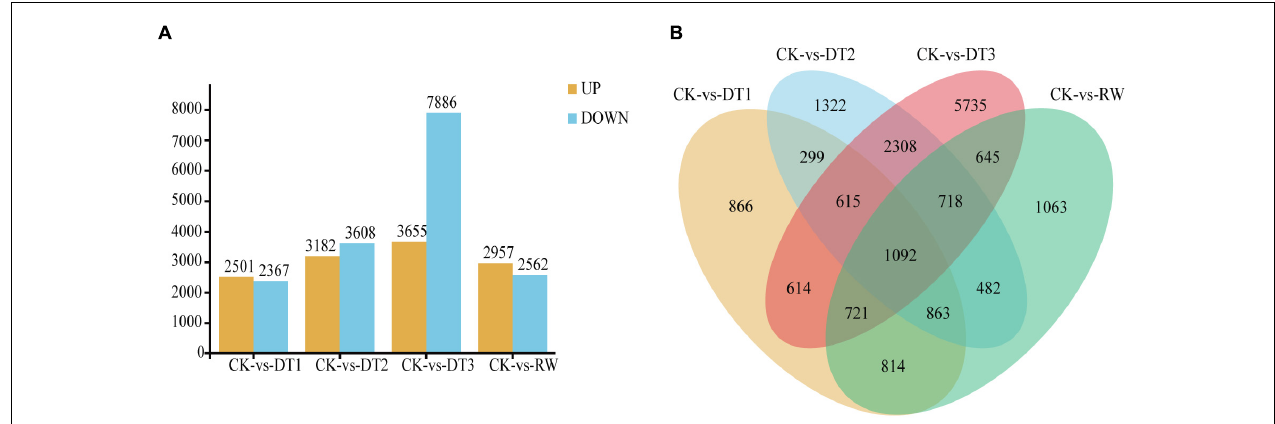
FIGURE 3 | RNA-seq data expression profiles during drought and rewatering treatment in Rosa chinensis ‘Old Blush.’ (A) The number of genes up-regulated and down-regulated in four drought and rewatering treatment stages compared with the control. Genes up-and down-regulated are shown as yellow and blue bars. (B) Venn diagram analysis of the DEGs from four drought and rewatering treatment stages compared with control plants.